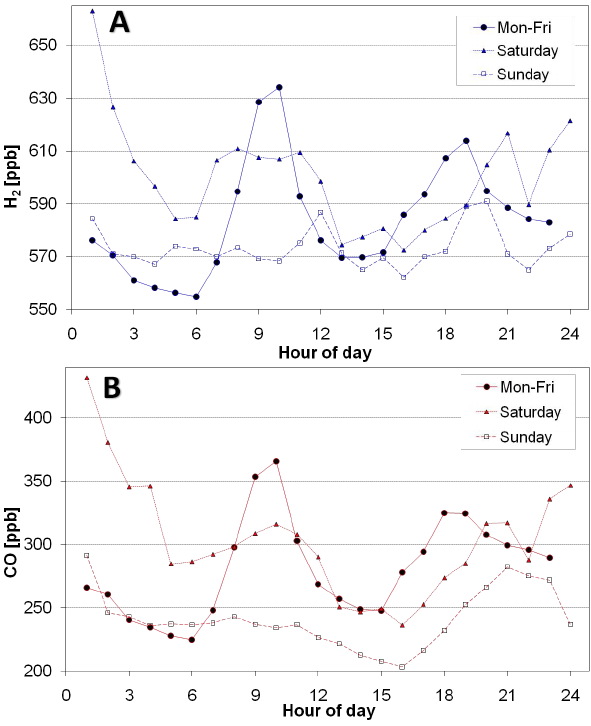
Fig. 5. Hourly averaged (a) H 2 and (b) CO data for weekdays (cir- cles) and Saturday (triangles) and Sundays (squares) for the entire measurement